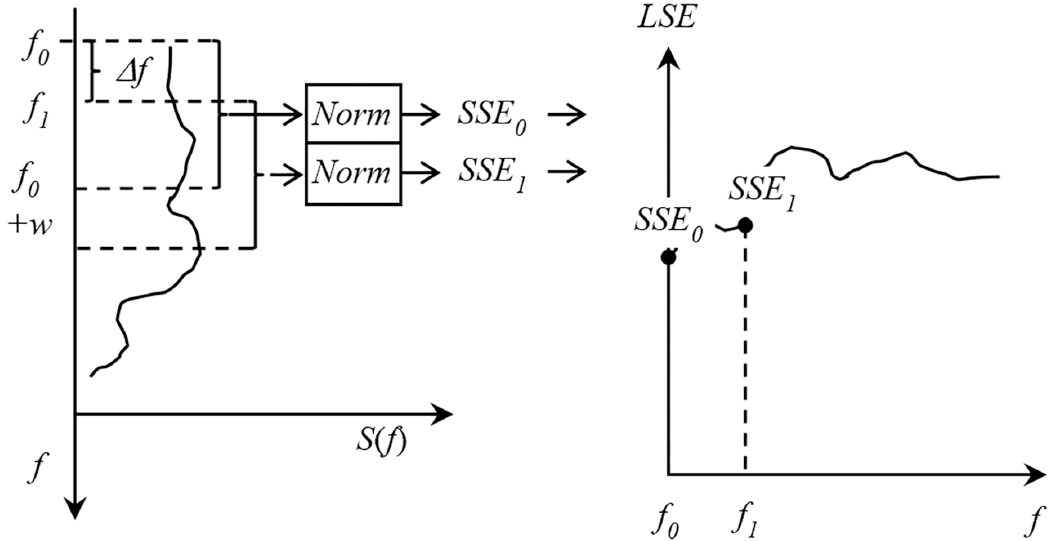
Fig 2. Local spectral entropy. Illustration of the proposedcalculationof the LSE from the spectral entropy of consecutive frequencybins.